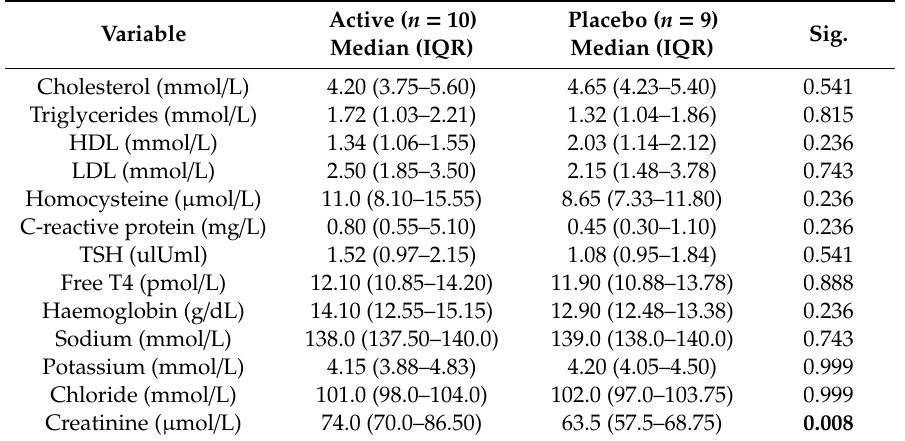
Table A9. Additional biochemical assessments measured in active and placebo intervention